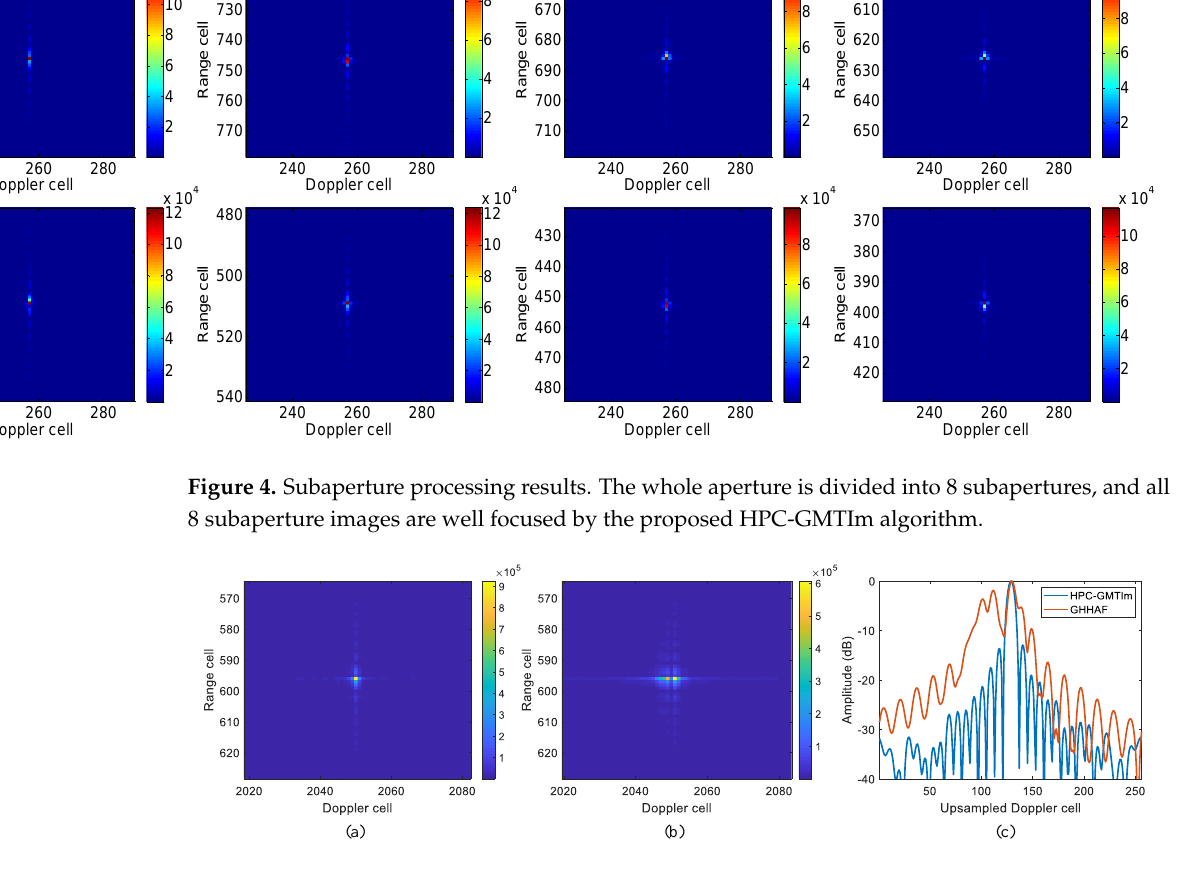
Figure 5. Whole aperture image. ( a ) HPC-GMTIm algorithm. ( b ) GHHAF method. ( c ) Cross-range profile comparison. Table 3. Focusing quality